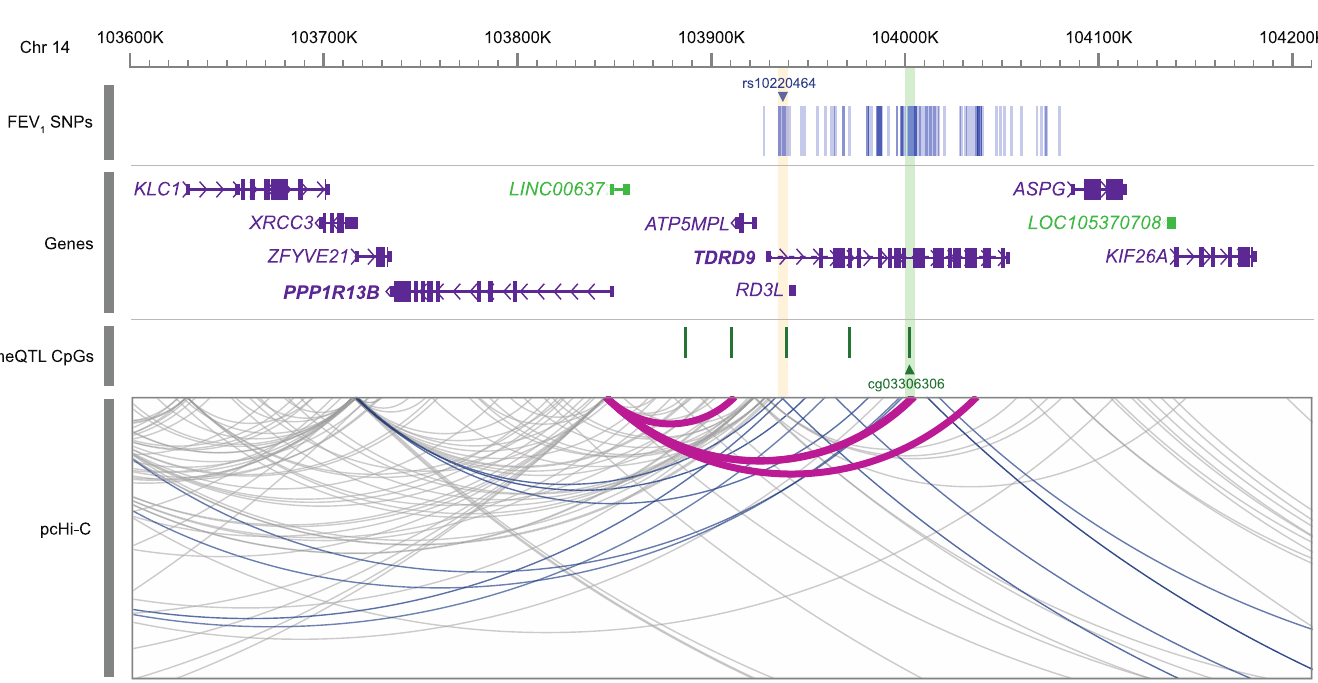
Fig 8. Promoter-enhancer interactions at TDRD9 locus in nasal epithelial cells. Promoter-to-enhancer chromatin interactions captured by Hi-C in nasal epithelial cells from URECA at age 11 are displayed as grey arcs. SNPs associated with FEV 1 (p < 1x10 -5 ) are marked by blue lines in the top row according to their genomic position on chromosome 14. The lead FEV 1 SNP, rs1022464, is highlighted in yellow. CpG sites associated with rs1022464 (FDR < 0.05) are displayed as green markers below the genes, with cg03306306 highlighted in green. Chromatin Interactions containing SNPs associated with FEV 1 (p < 1x10 -5 ) are highlighted in blue. Magenta arcs highlight interactions between the PPP1R13B promoter and regions containing FEV 1 SNPs and/or rs1022464-associated CpG sites. FEV 1 , forced expiratory volume in one second; SNPs, single nucleotide polymorphisms; meQTL, methylation quantitative trait locus; pcHi-C, promoter capture Hi-C.